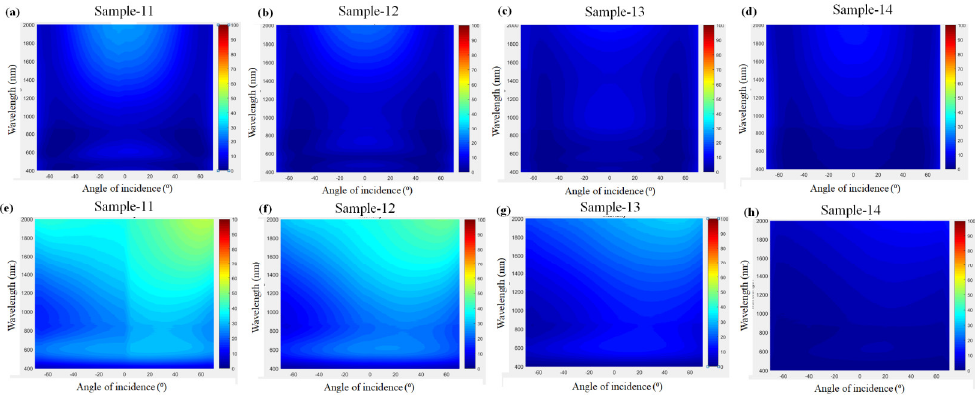
Figure 9. Measured p-polarized ( a – d ) reflectance and ( e – h ) transmittance versus wavelength and angle of incidence for TiN NRA.